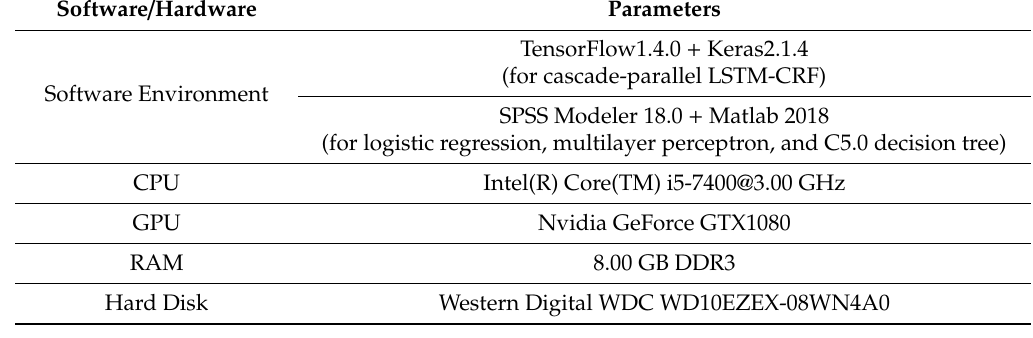
Table 1. Software environment and hardware configuration in the experiment.